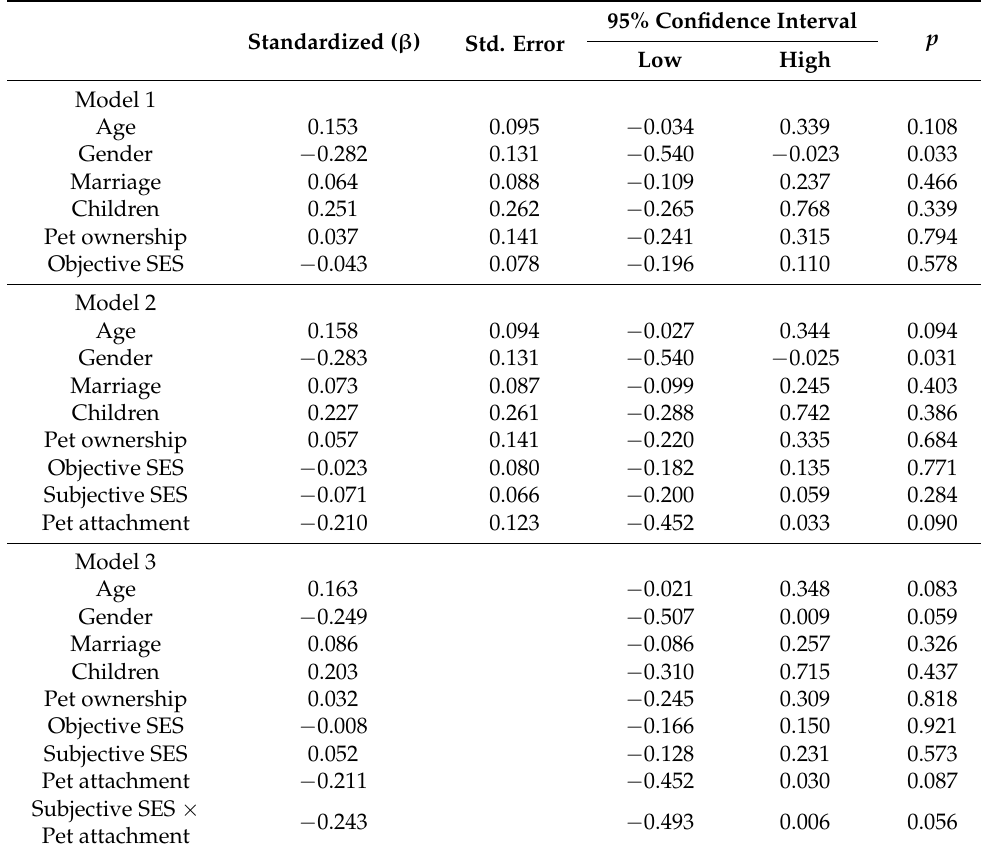
Table 5. Summary of the hierarchical regression model coefficients ( N =